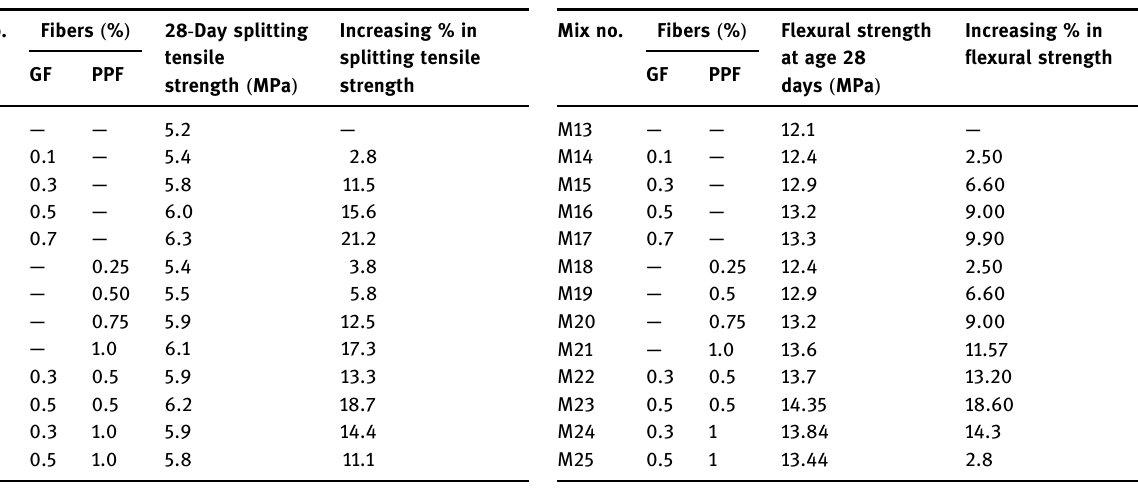
Table 16: Flexural strength test results of HSC